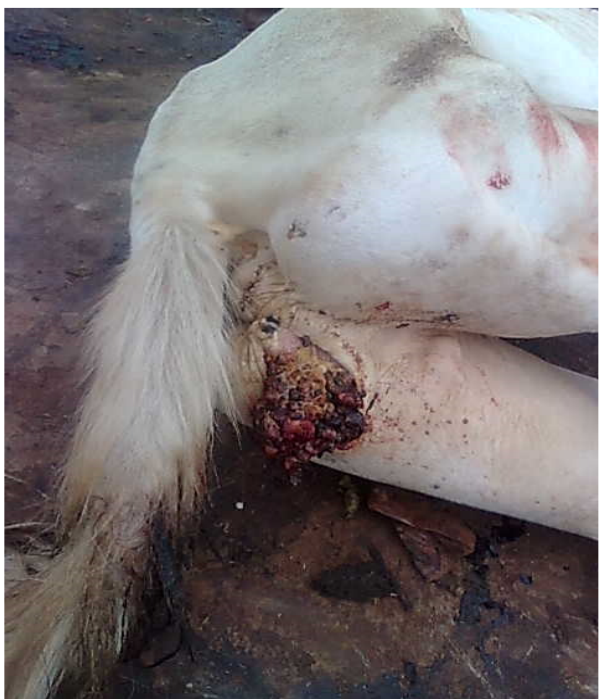
Fig. 1. Proliferative fleshy mass with an irregular surface and multifocal necrotic areas protruding from the vagina and vulva of a mare